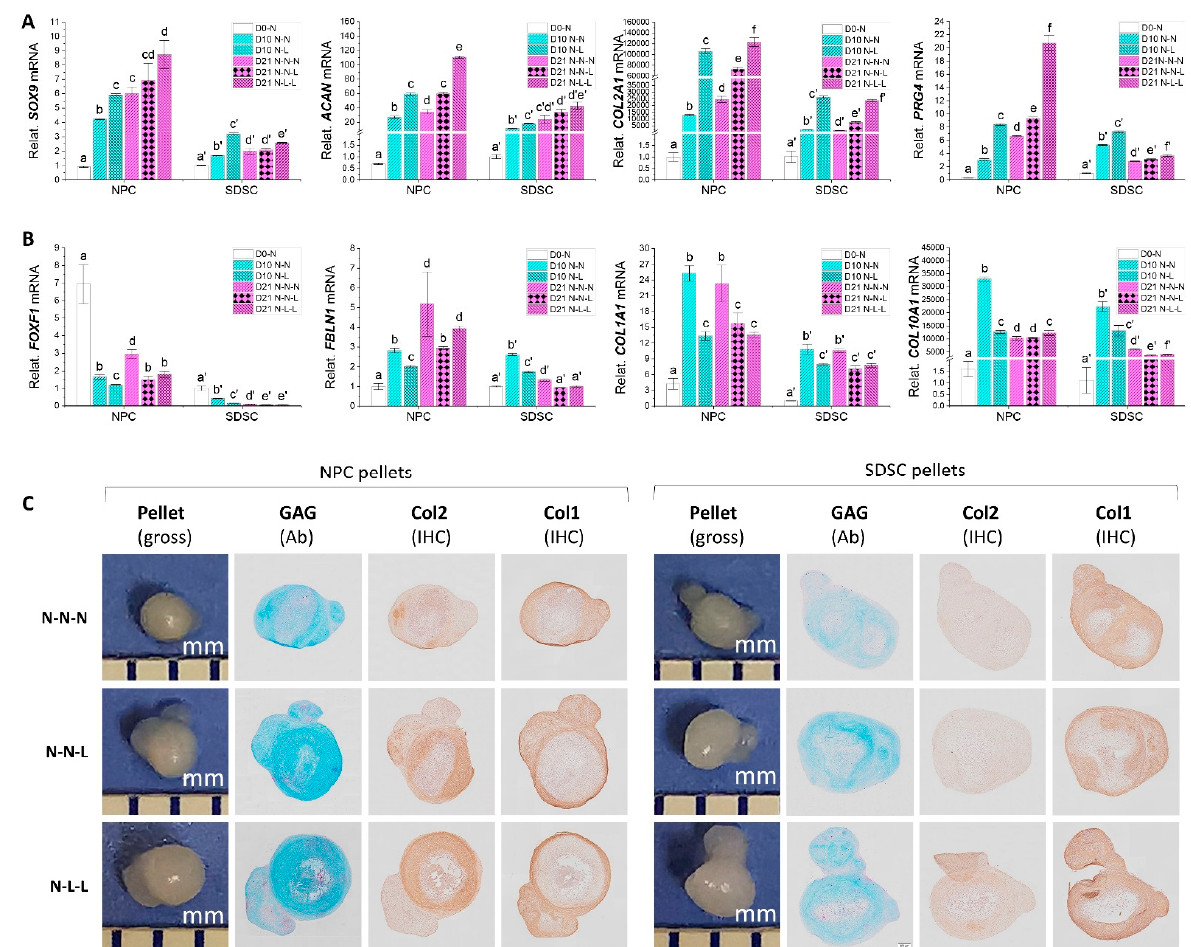
Figure 7. Evaluation of the effect of hypoxia on chondrogenic differentiation of fetal MSCs. RT-qPCR was used to assess the expression of chondrogenic marker genes ( SOX9 , ACAN , COL2A1 , and PRG4 ) ( A ) and chondrogenic related genes ( FOXF1 , FBLN1 , COL1A1 , and COL10A1 ) ( B ) in days 0, 10, and 21 pellets, normalized against GAPDH levels as an internal control. Data ( n = 4) are represented in bar charts. Different letters indicate a statistically significant difference compared to the group